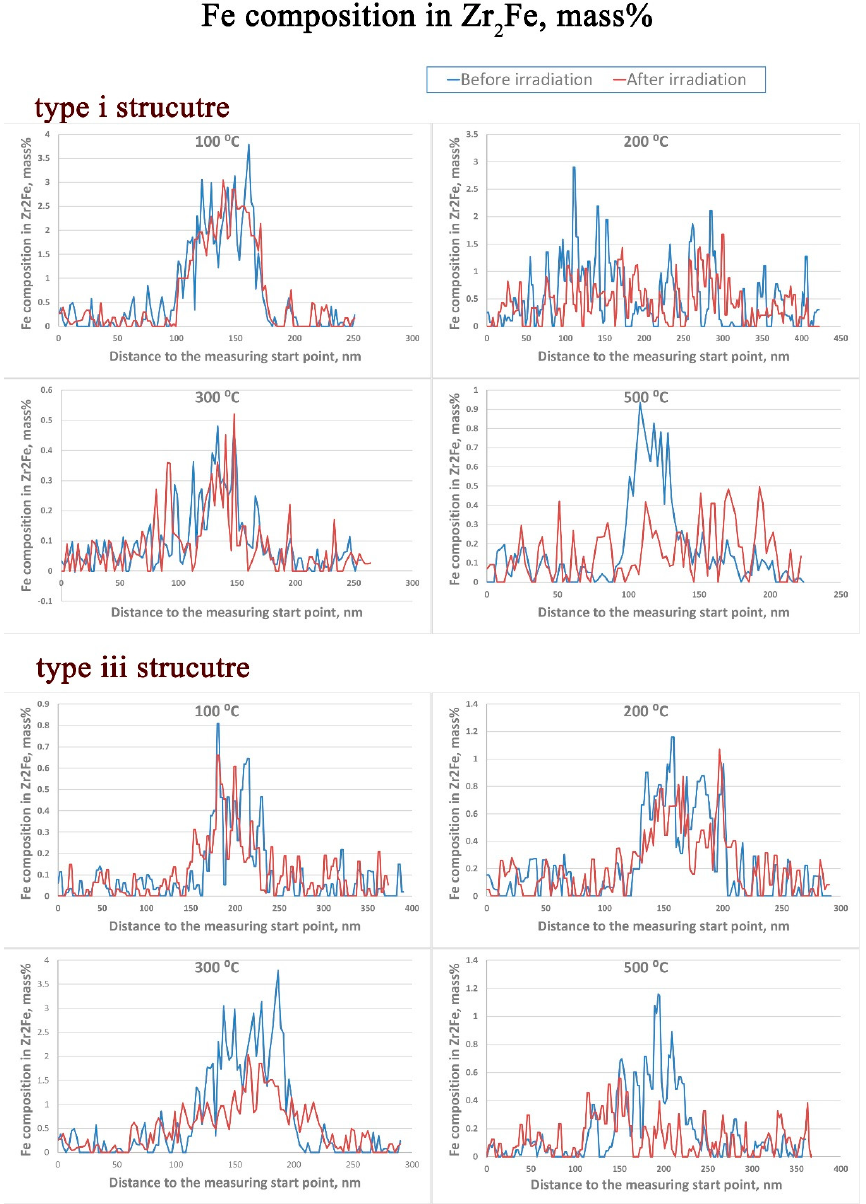
Figure 12. The concentration change of Fe in Zr 2 Fe precipitates in type i and iii structures before and after irradiation at 100 °C, 200 °C, 300 °C, and 500 °C.